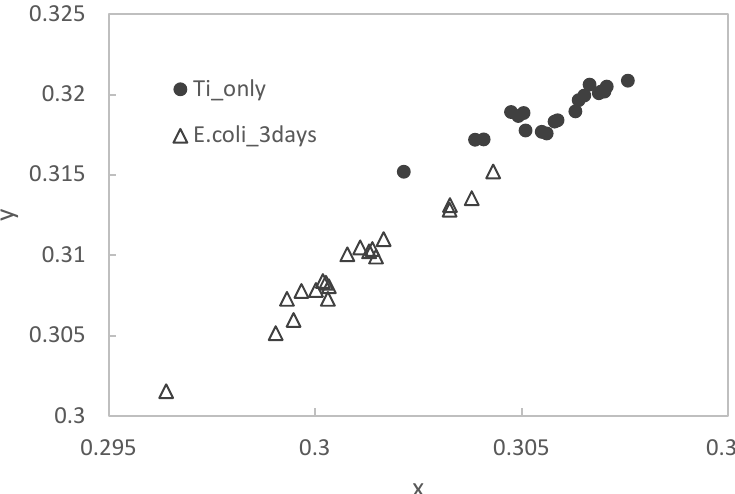
Figure 7. Color changes based on image analyses and calculations.